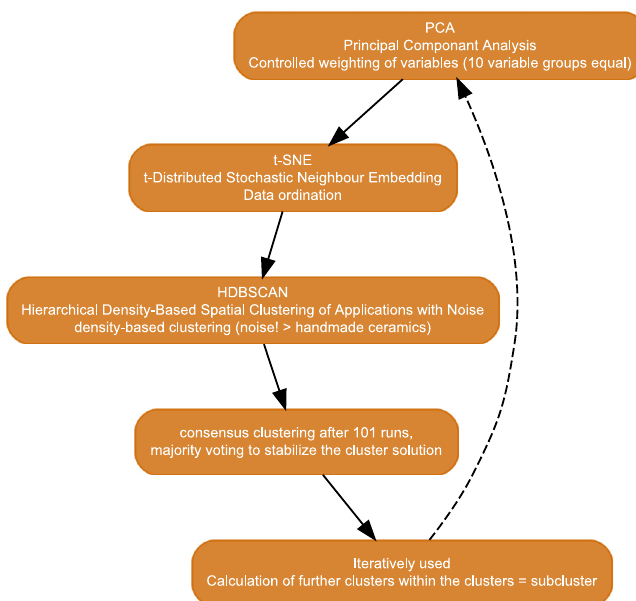
Figure 4: Full work fl ow of the computer - aided classi fi cation ( fi gure: M. Hinz )